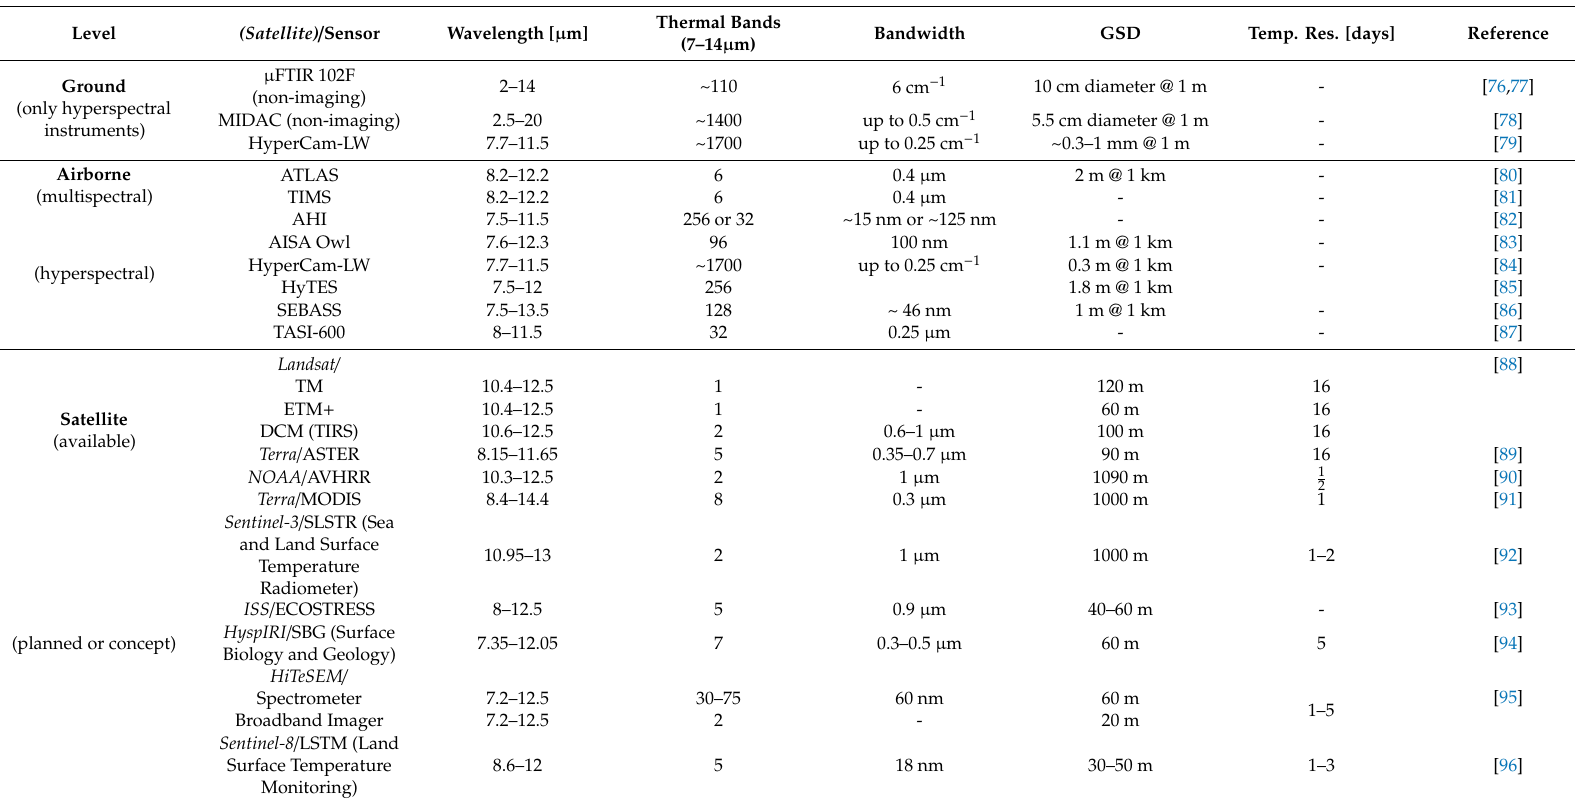
Table 2. Current available and planned TIR sensors at ground, airborne, and satellite level. The table should provide an overview without claiming to be exhaustive. Level Ground (only hyperspectral instruments)